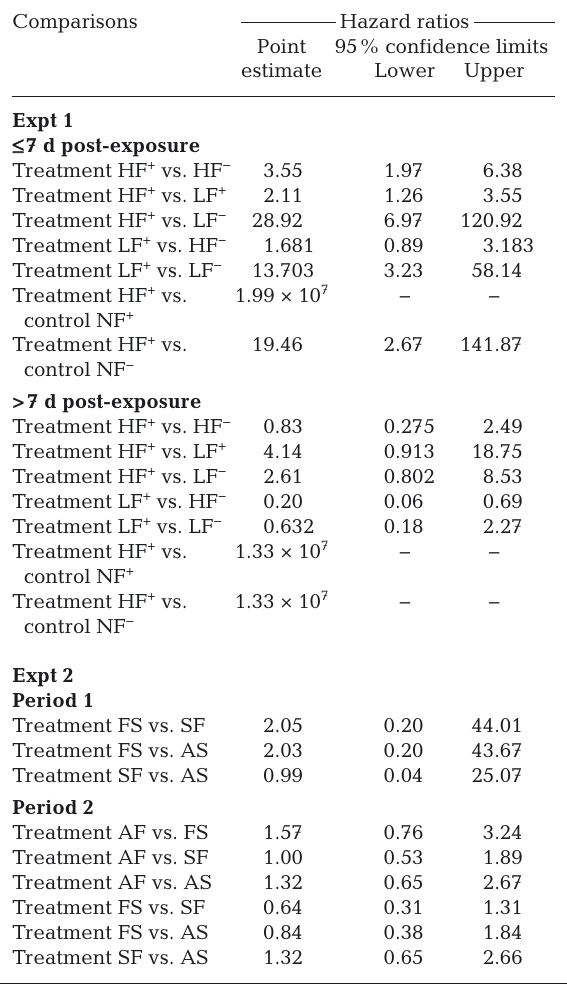
Table 3. Cox’s proportional hazards for Expts 1 & 2. Period 1: Days 1−8 (OsHV-1 infected donors present Days 1−4; n =